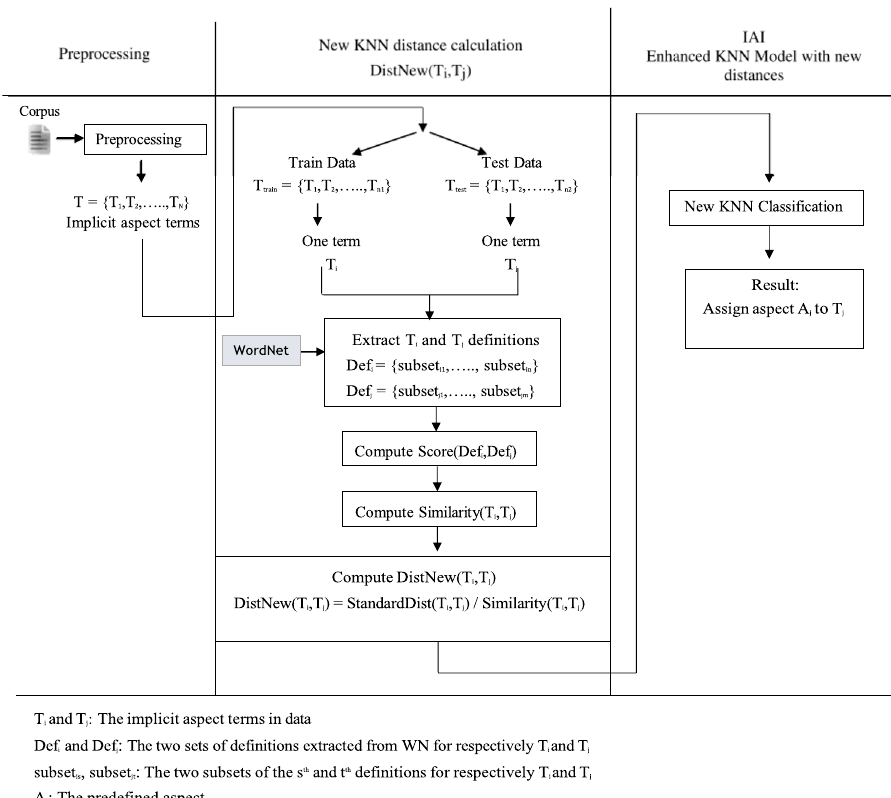
Fig. 1 Summary of our